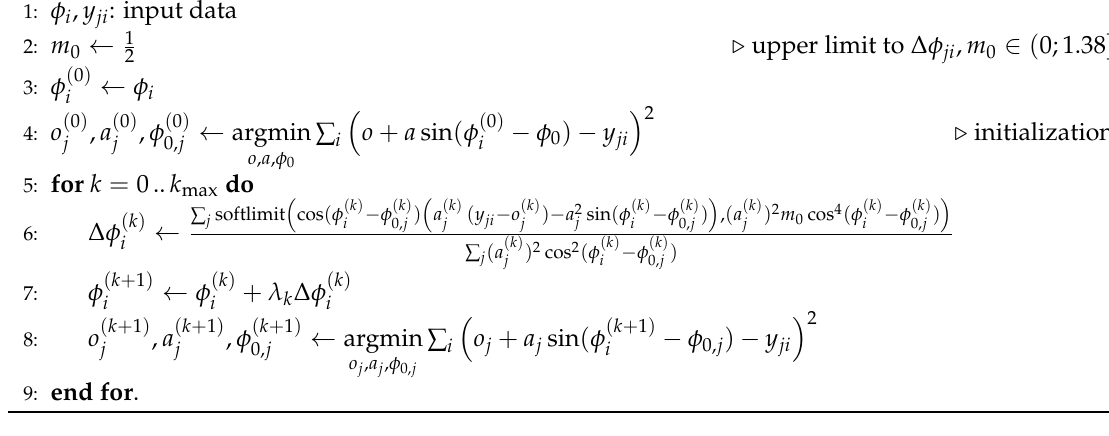
Algorithm 1 Least squares optimization of shared abscissa values φ i for simultaneous sinusoid fits to ordinate samples y ji belonging to independent curves j sampled at identical positions φ i . This represents a special case of Algorithm 2 with spatially invariant sampling phases. The relaxation parameter λ k ∈ ( 0; 1 ] may be chosen <1 if damping of the updates to φ intermediate argmin operations, see Equations (2)–(5).